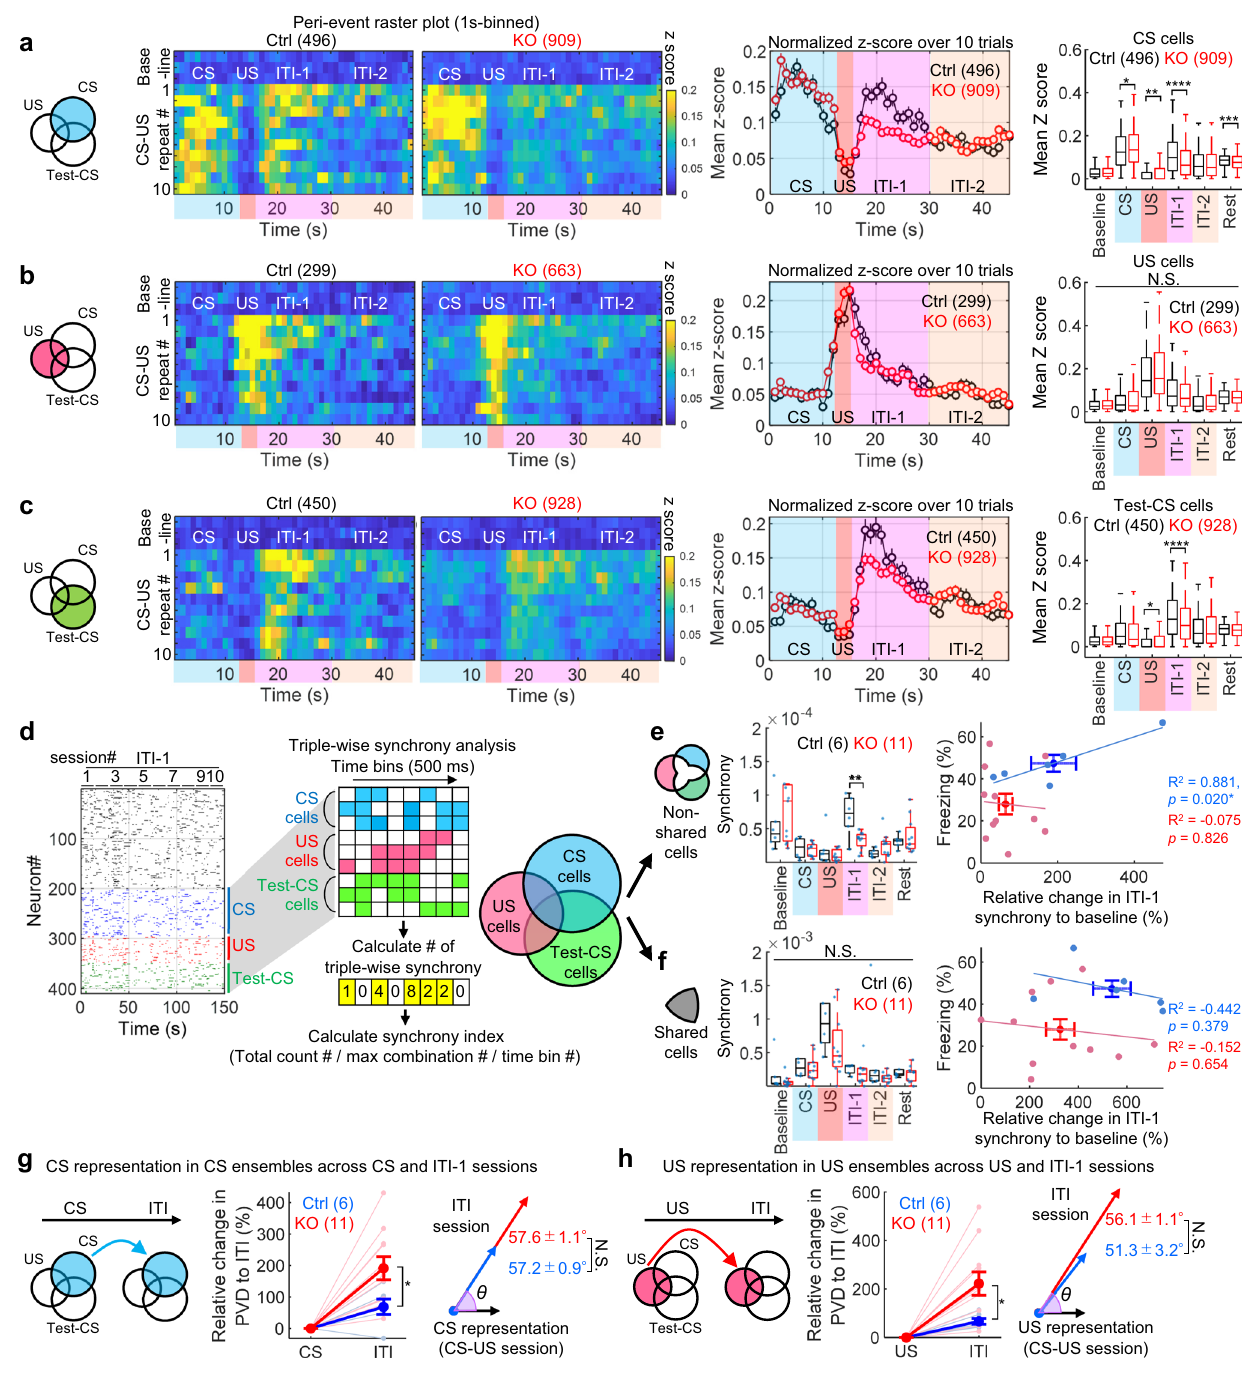
Fig. 3 | CA3 NRs are involved in reverberatory and synchronized activity, but not sensory propagation, in CS- and Test-CS-responsive CA1 ensembles. a-c Left, Venn diagrams representing ( a ) CS-, ( b ) US-, and ( c ) Test-CS-responsive ensembles. Peri-event raster plots during the training session in each subpopula- tion of littermate control and KO mice. Each short vertical tick represents a 1s changeofmeanz-scoreacrossbaselineandtenCS-USpairings.Ca2 + activitieswere aligned at the time that CS-US stimuli were delivered. The color code represents mean z-score. Middle, averaged z-score plots over ten CS-US pairings in each subpopulation. Right, box plots comparing mean z-scores between genotypes in each session (two-tailed unpaired Wilcoxon rank sum test for CS cells: CS, P =0.045; US, P =0.004; ITI-1, P =5.9E-10; Rest, P =5.9E-10; for Test-CS cells: US, P =0.011; ITI-1, P =0.00005). d Left, representative binarized raster plots of Ca2 + activity across ten ITI-1 sessions in control animals. Right, magni fi ed raster plots focusing on CS-, US-, and Test-CS-responsive subpopulations and scheme for synchrony analysis. This analysiscalculates synchrony by normalizing the number